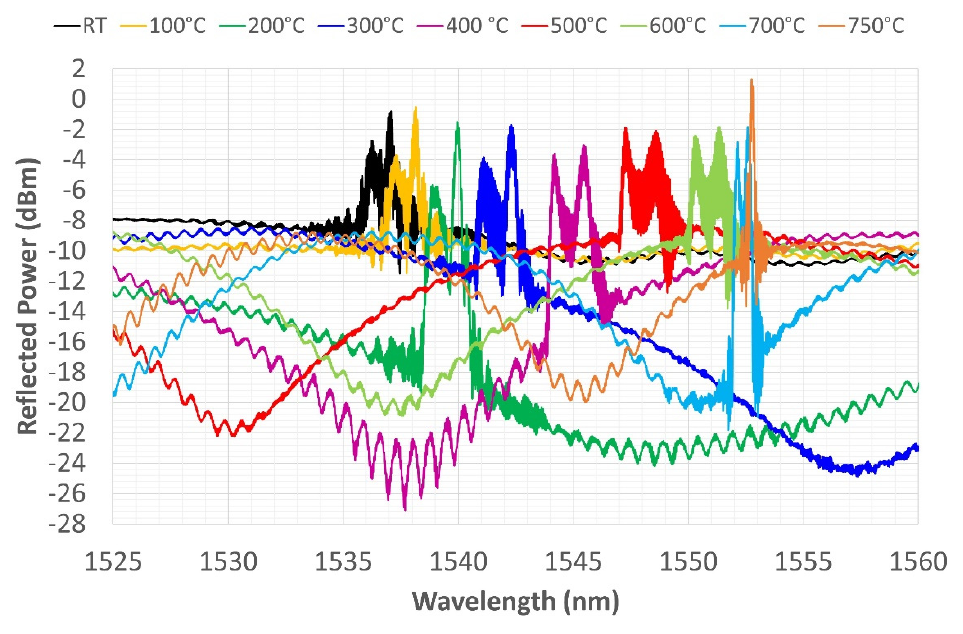
Figure 10. Second thermal cycle—grating reflected spectrum change during heating from RT to 750 °C.